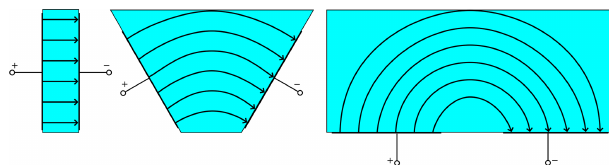
Figure 1. Gradual transition from a parallel plate capacitor to a planar capacitor, adapted from Mamishev et al. (2004).